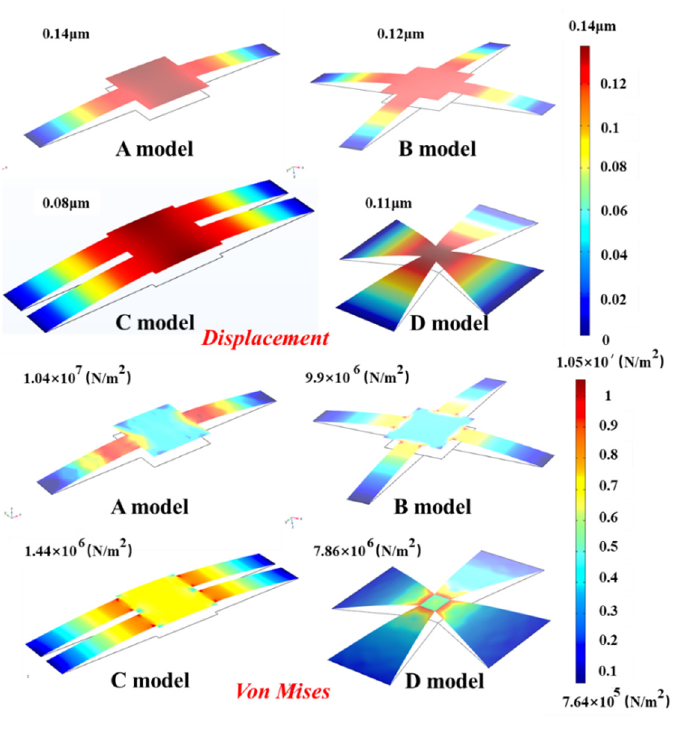
Figure 4. Mechanical simulation analysis of the TLGE.